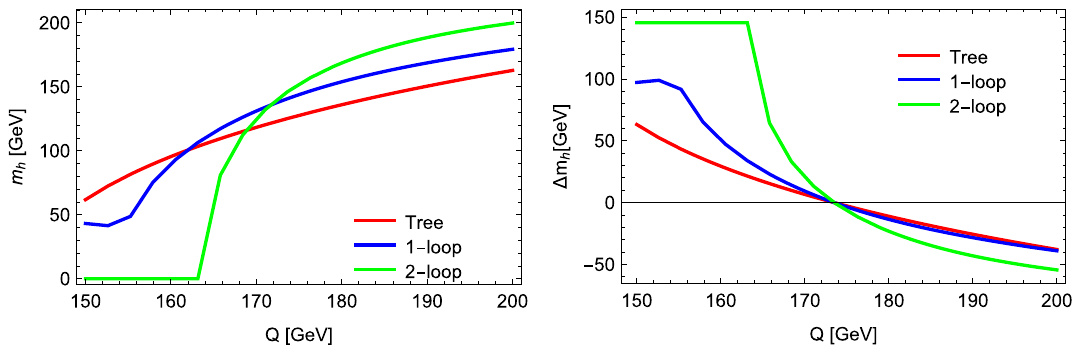
Fig. 8 The dependence of the lightest scalar mass as function of the renormalisation scale Q if the quartic couplings of Eq. (6.17) are used as input at the scale Q = m t